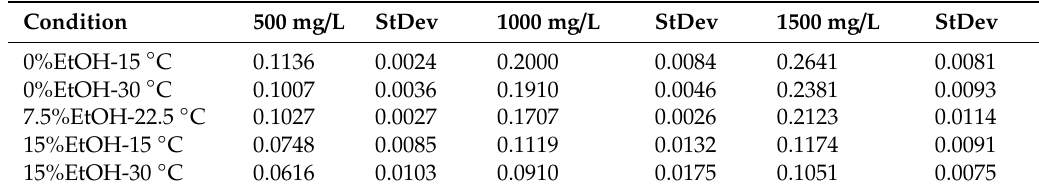
Table A3. Average mass PA adsorbed to cell wall material after system reached equilibrium in the absence of anthocyanins. Values derived from previous study [7] and represented in Figure 6. Values are presented in mg PA (C.U.) per mg CWM ( n = 3). Respective standard deviations are displayed to the right of each data point.